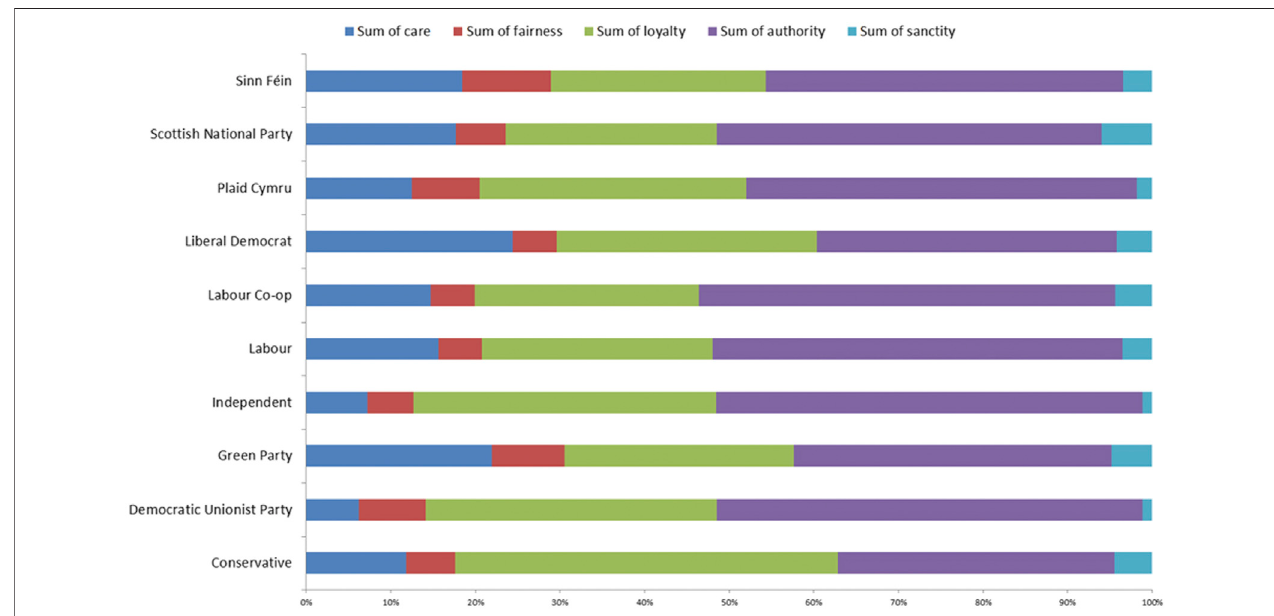
FIGURE 5 | Stacked bar graph showing the proportion of moral intensity for each moral foundation, per party. We see that most parties generally used arguments of Authority, Loyalty and Care.